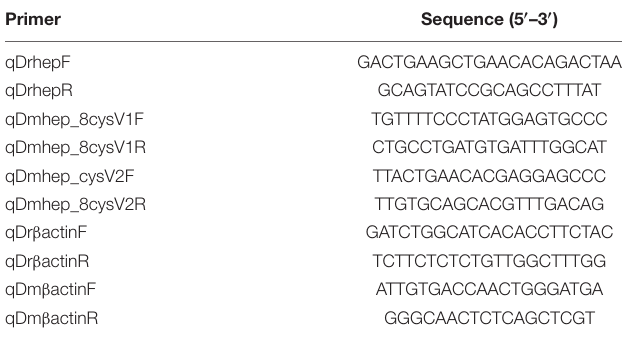
TABLE 1 | Primers for quantification of D. mawsoni and D. rerio hepcidin mRNA by real time quantitative PCR.